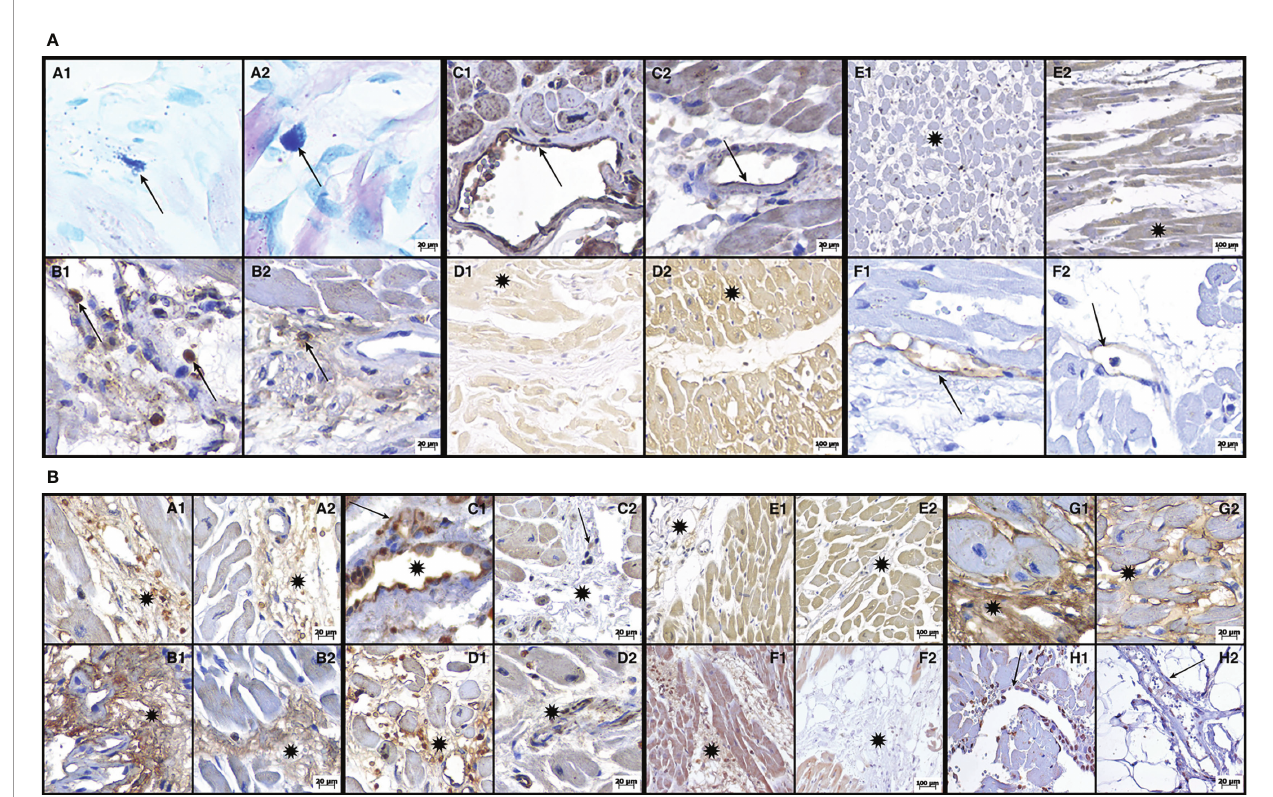
FIGURE 1 | (A) Photomicrographs demonstrating histochemical (A1/2 - Toluidine Blue) and immunohistochemical (B = CD163; C = Casp-1; D = Casp-9; E = GSDM-D; F = ICAM-1) reactions of both groups: cases of COVID-19 (B1-F1) and cases of their respective controls (B2-F2). A1 (COVID-19) and A2 (control) show a mast cell in the perivascular space (arrows): in A1 the mast cell is degranulated, whereas in A2, the mast cell is intact. B1 (COVID-19) shows CD163-immunostained macrophages (arrows) in the myocardial interstitium, whereas in B2 (control) these CD163 macrophages (arrow) are less numerous. C1 (COVID-19) shows endothelial cells (arrow) with strong expression of Casp-1, whereas in C2 (control), Casp-1 expression in endothelial cells (arrow) is much more discrete. D1 (COVID- 19) shows a weak expression of Casp-9 in the myocardium (asterisk), whereas in D2 (control), this expression is strong (asterisk). E1 (COVID-19) shows a weak expression of GSDM-D in the myocardium (asterisk), with E2 (control) showing a strong expression (asterisk). F1 (COVID-19) shows a strong expression of ICAM-1 in endothelial cells (arrow), whereas, in F2 (control), this expression is discrete (arrow). (B) Photomicrographs demonstrating immunohistochemical reactions (A = TNF- a ; B = MMP-9; C = IL-4; D = IL-6; E = IL-1 b ; F = TGF- b ; G = collagen 3; H = TUNEL) from both groups: cases of COVID-19 (A1-H1) and their respective controls (A2-H2). A1 (COVID-19) shows myocardial interstitium expressing TNF- a (asterisk), whereas, in A2 (control), we can observe that this expression is